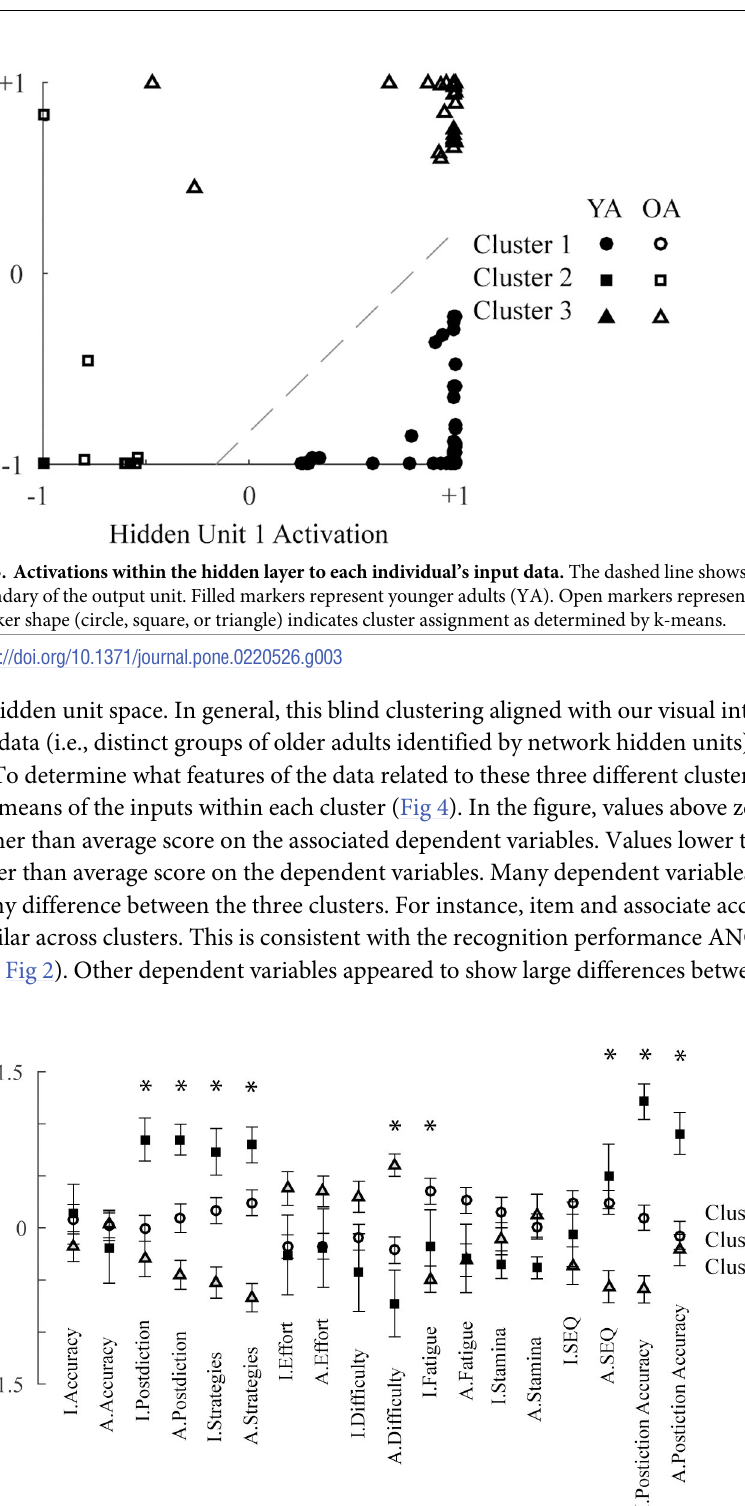
Fig 4. Mean normalized scores on each variable used as input for the network. Error bars show standard errors of the mean. Asterisks mark inputs showing significant differences between clusters (Bonferroni corrected). Partial eta squared effect sizes for significant effects in the neural network clusters are (left to right): .88, .91, .92, .95, .93, .90, .91, .96,